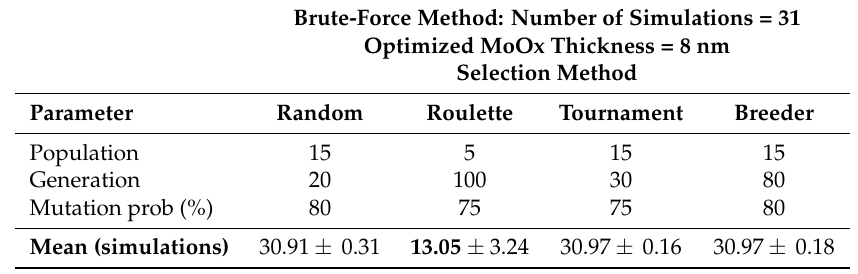
Table 2. Comparison results for MoOx single-layer optimization.